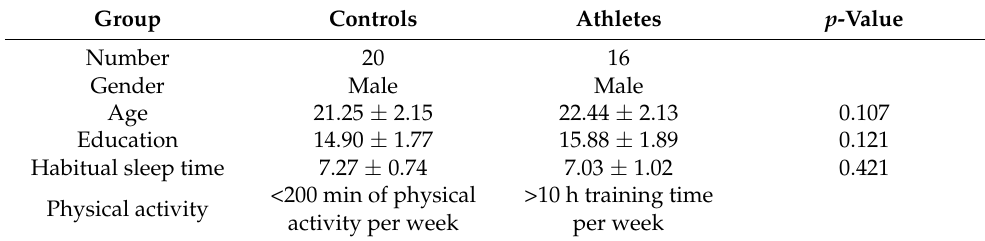
Table 1. Demographic information of each group (M ± SD). Group